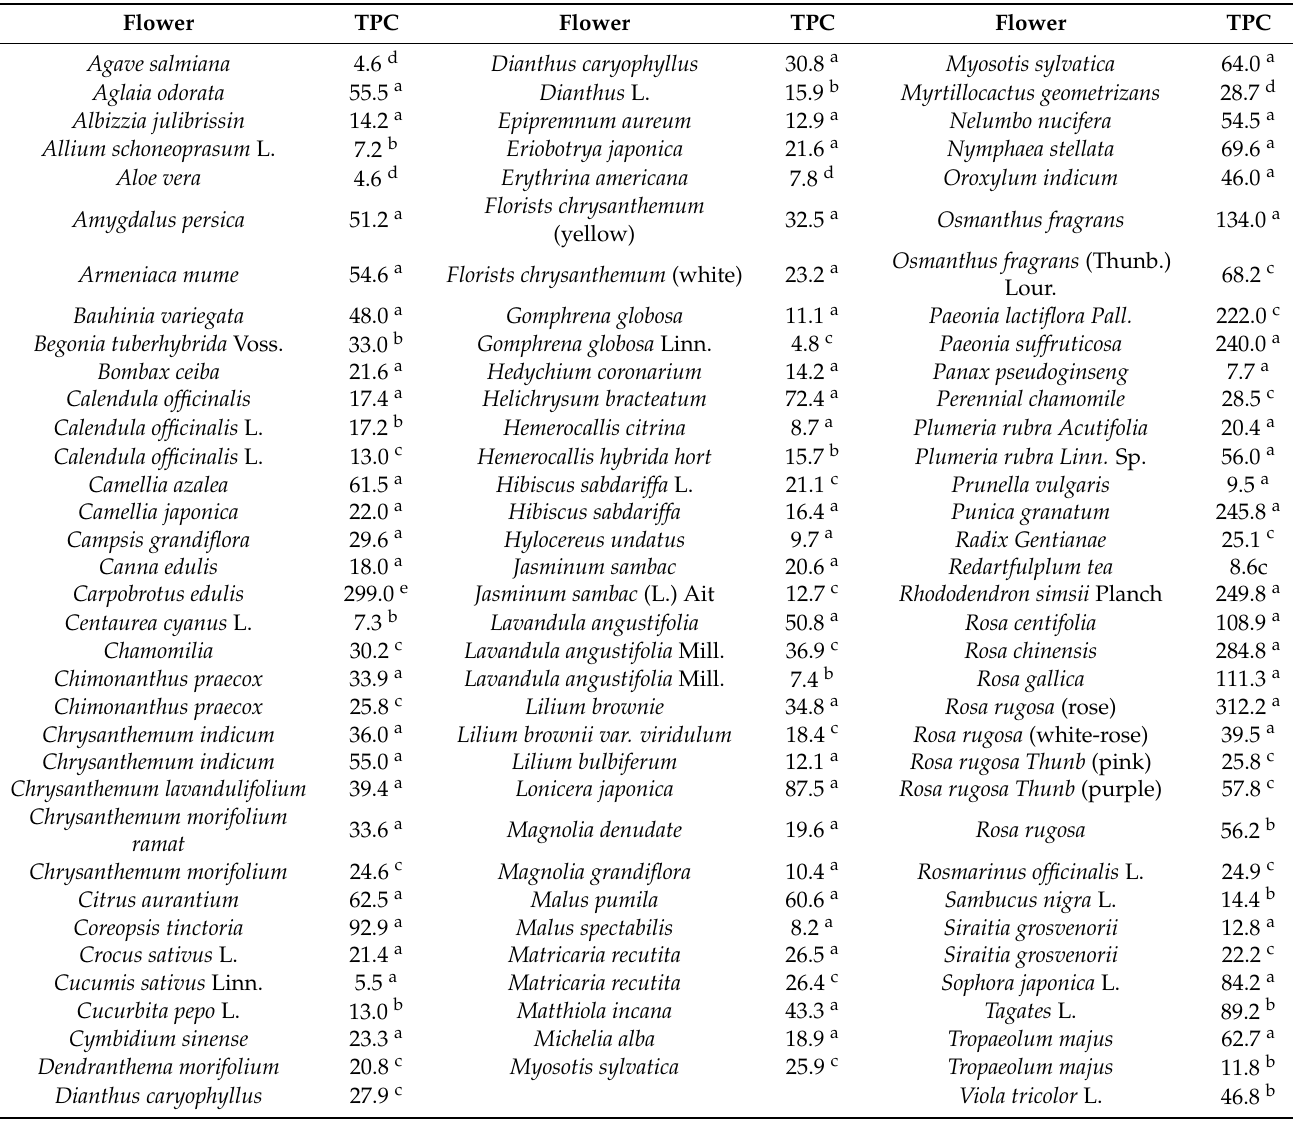
Table 1. Total phenolic content (mg GAE/g DW) of several edible